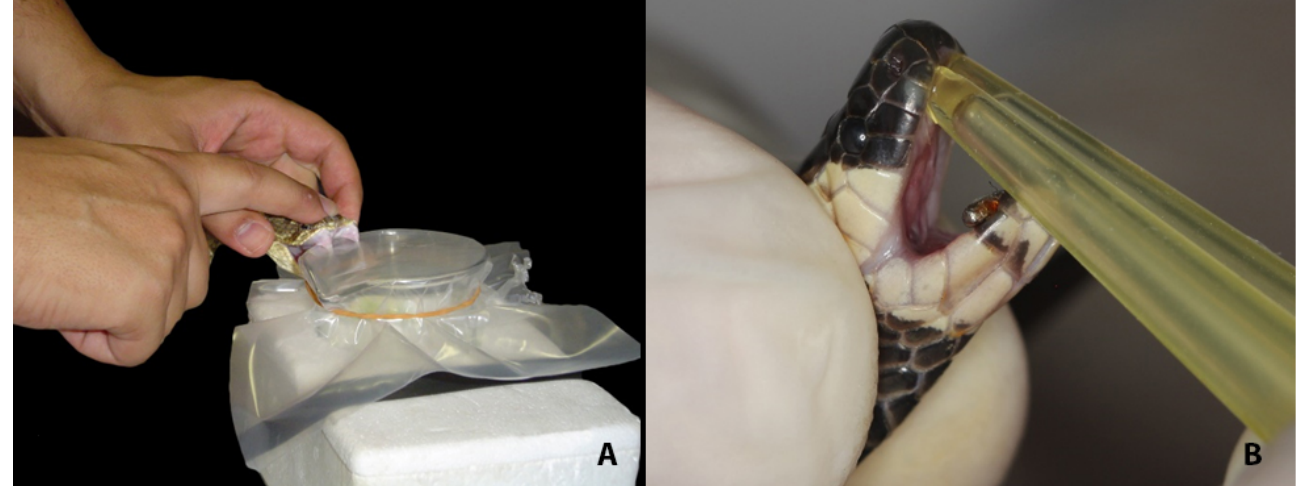
Figure 4. (A) Venom extraction in Crotalus sp. performed in a glass Beaker covered with a thick plastic sheet, immersed in ice bath. (B) Venom extraction in coral snake performed with tips connected to the proteroglyphous